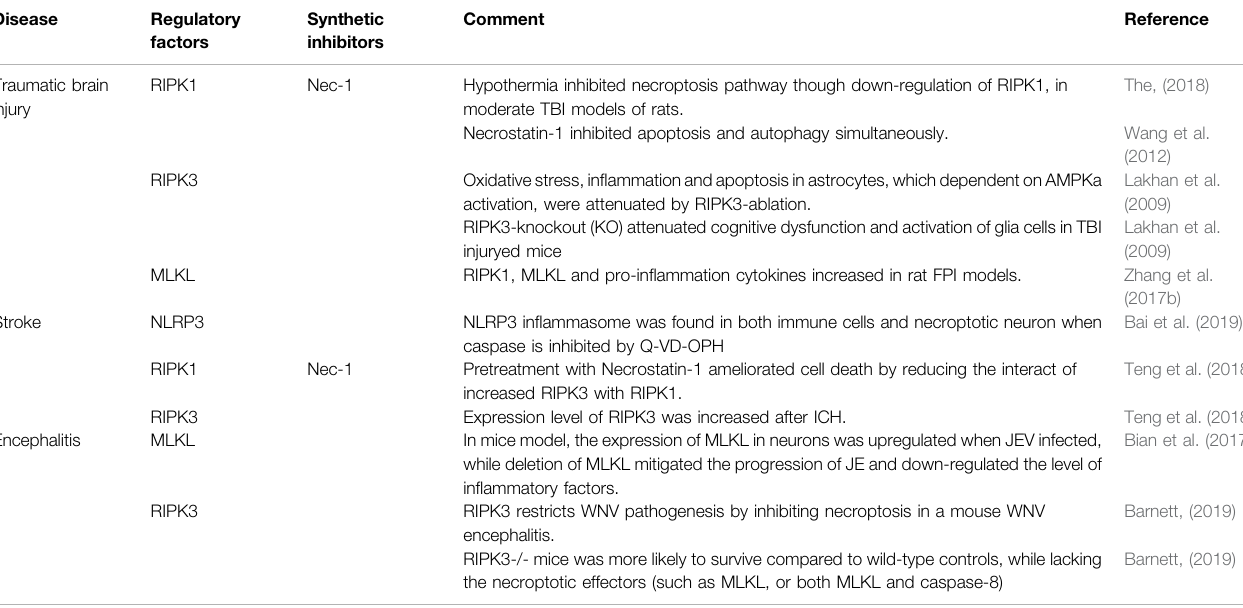
TABLE 1 | Necroptosis in acute neurodegenerative diseases.